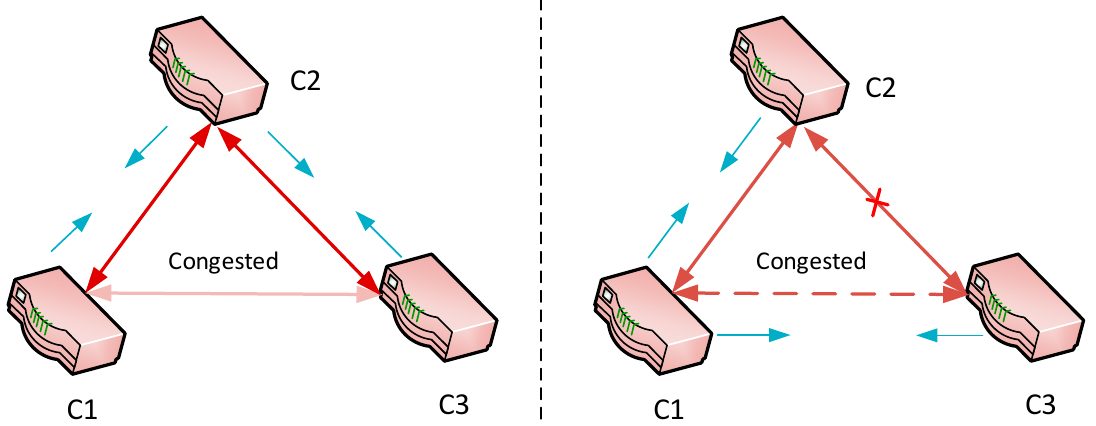
Figure 7. The control plane adaptation: ( Left ) the congested situation: C1 and C3 use the forwarding link via C2; ( Right ) link disruption: C1 and C3 use the congested control link with adapting information exchange frequency.